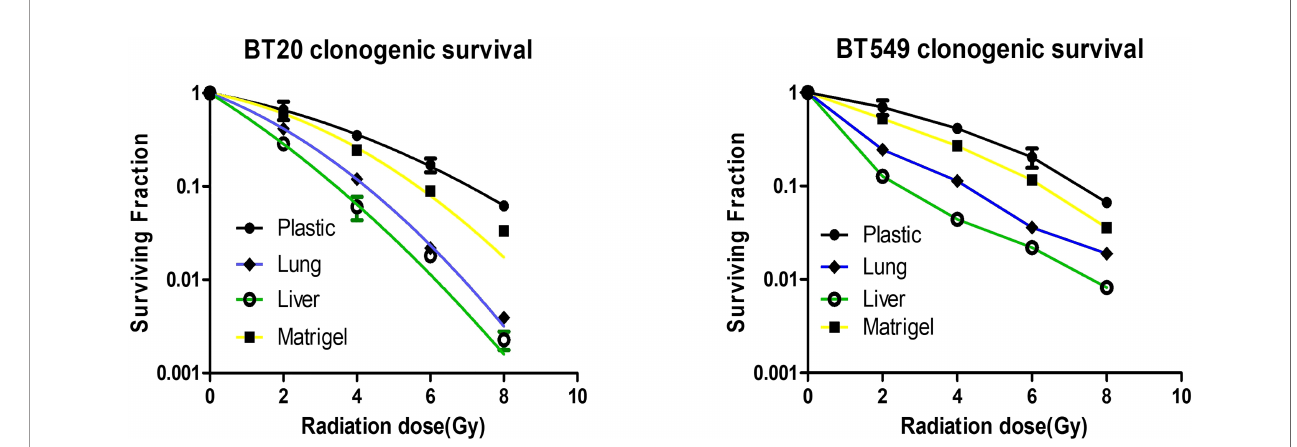
FIGURE 4 | Breast cancer cells grown on different substrata respond differently to radiotherapy. Response of breast cancer cells grown on plastic, Matrigel, liver BMSs, and lung BMSs to radiotherapy (n = 3 biologically independent cell samples). Data represent mean ±